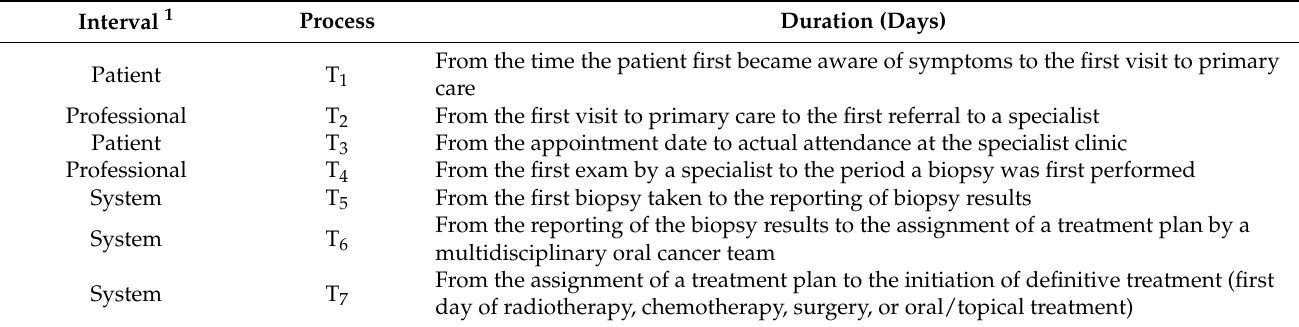
Table 1. Breakdown of intervals in